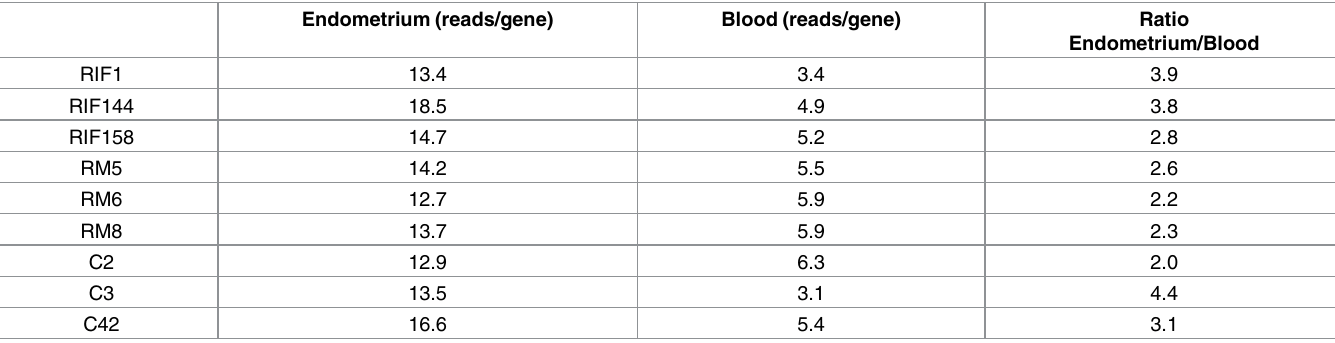
Table 1. The median expression of genes in each paired samples.